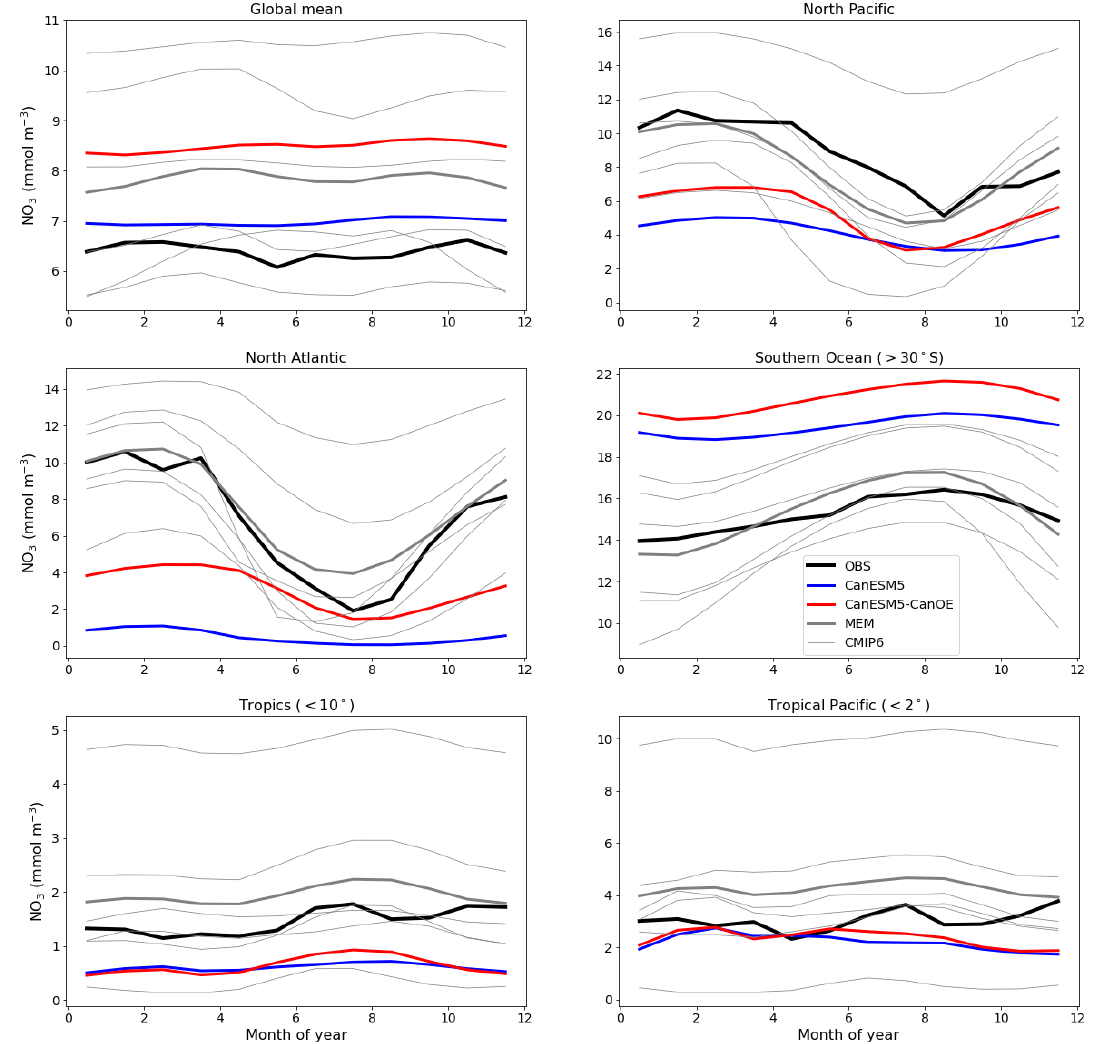
Figure 10. Climatological seasonal cycle of surface nitrate concentration averaged for selected ocean regions. The thick red line represents CanESM5-CanOE, thick blue line CanESM5, thick black line observations (WOA2018), thin grey lines individual CMIP6 models, and thick grey line the model ensemble mean (excluding CanESM5 and CanESM5-CanOE). Regional boundaries are given in Table S5 and Fig.